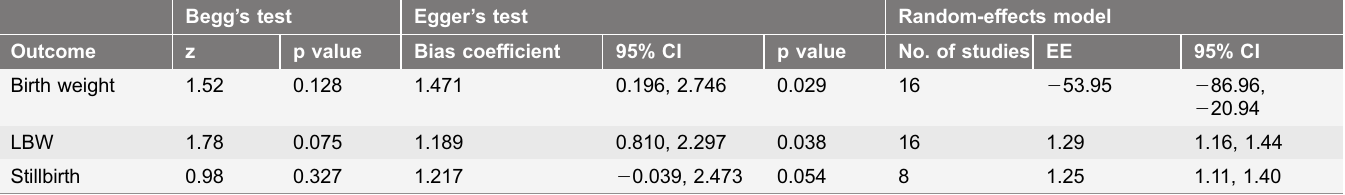
Table 4. Test for publication bias and adjusted summary-effect estimates. Begg’s